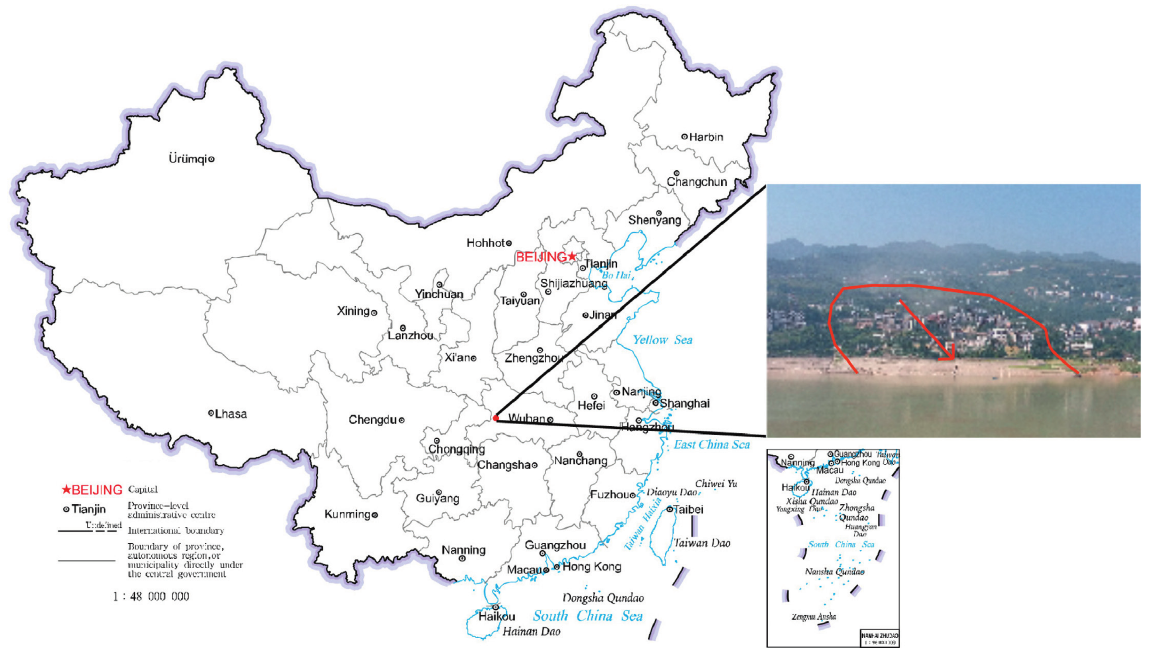
Figure 1: The Huangtupo No. 1 riverside sliding mass. Table 1: Basic physical and mechanical properties of sliding zone soil.